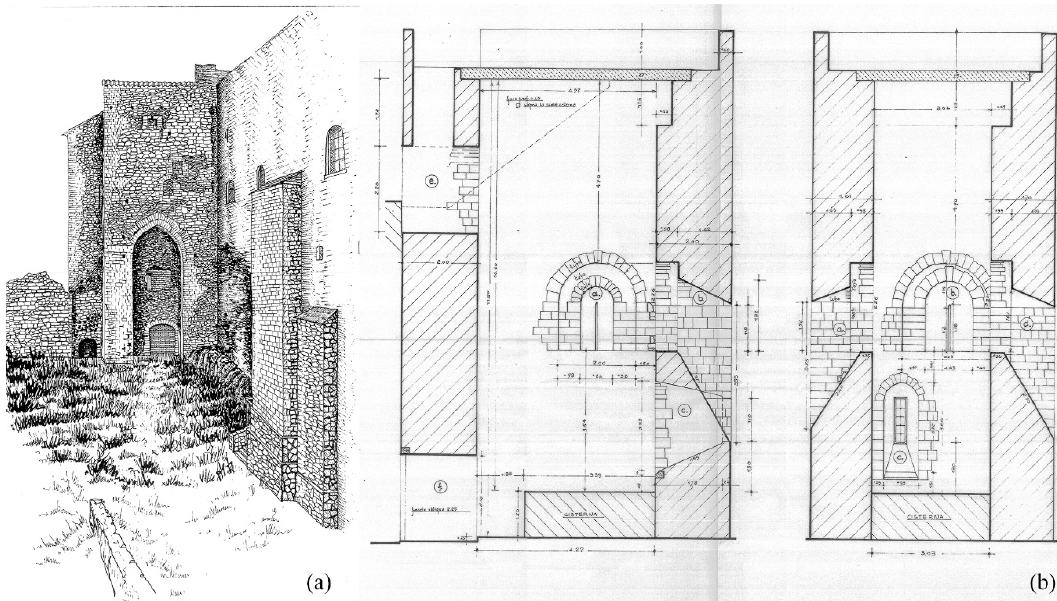
Figure 4. Perspective view of the North-East Tower ( a ) and two internal sections of the Church Tower ( b ), elaborated at the end of the 1980s within a project of post-earthquake consolidation.